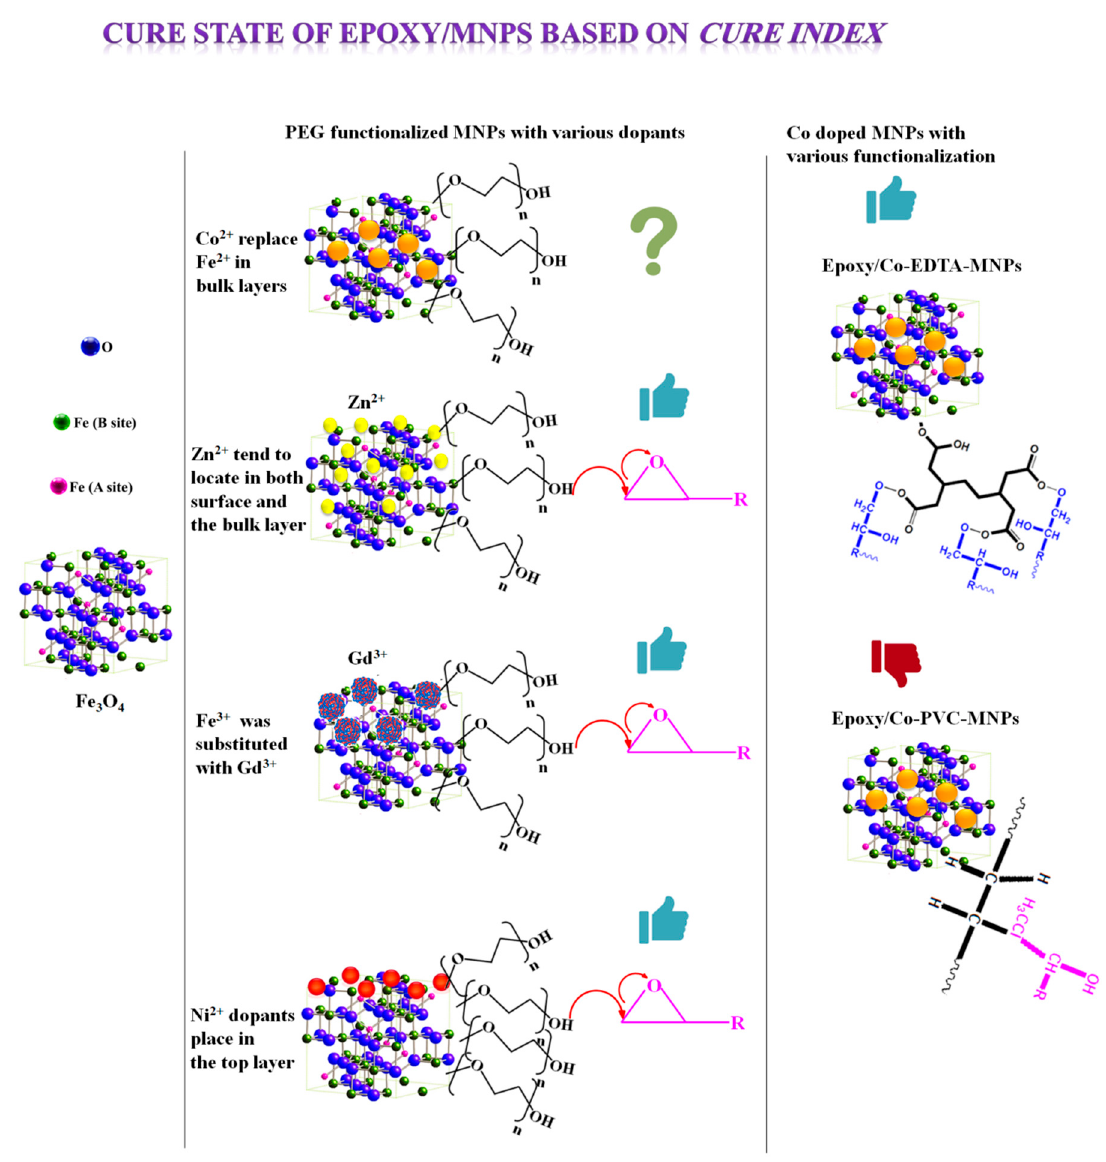
Figure 1. Cure state of epoxy/MNPs as model nanocomposite in which MNPs underwent various bulk and surface modifications, where shows Good cure state, while denotes Poor cure state.